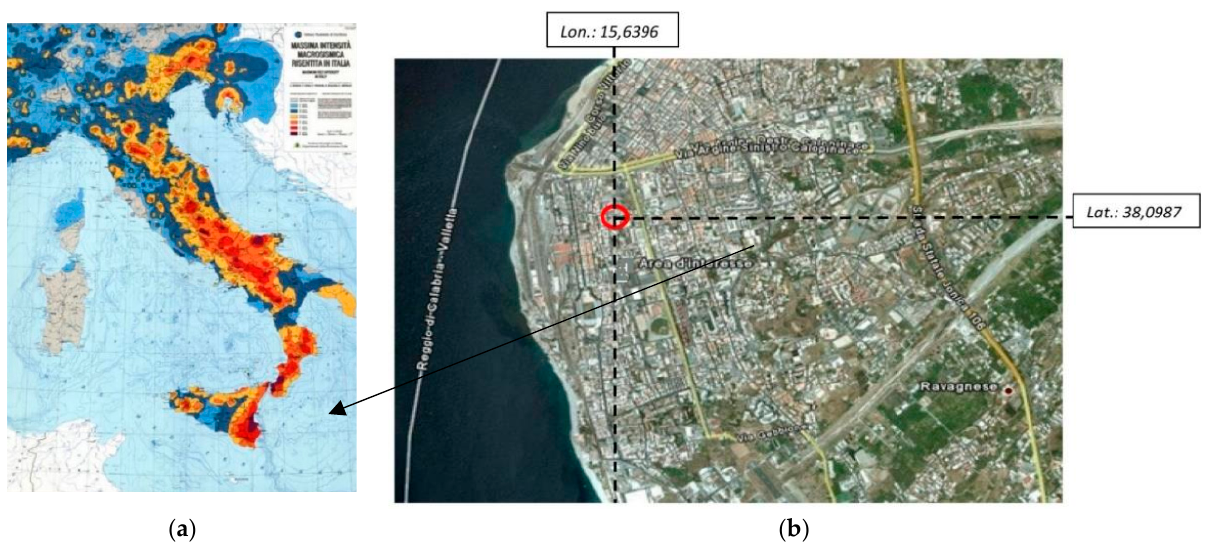
Figure 1. Building context: ( a ) Italian seismicity and ( b ) location of the case-study system.